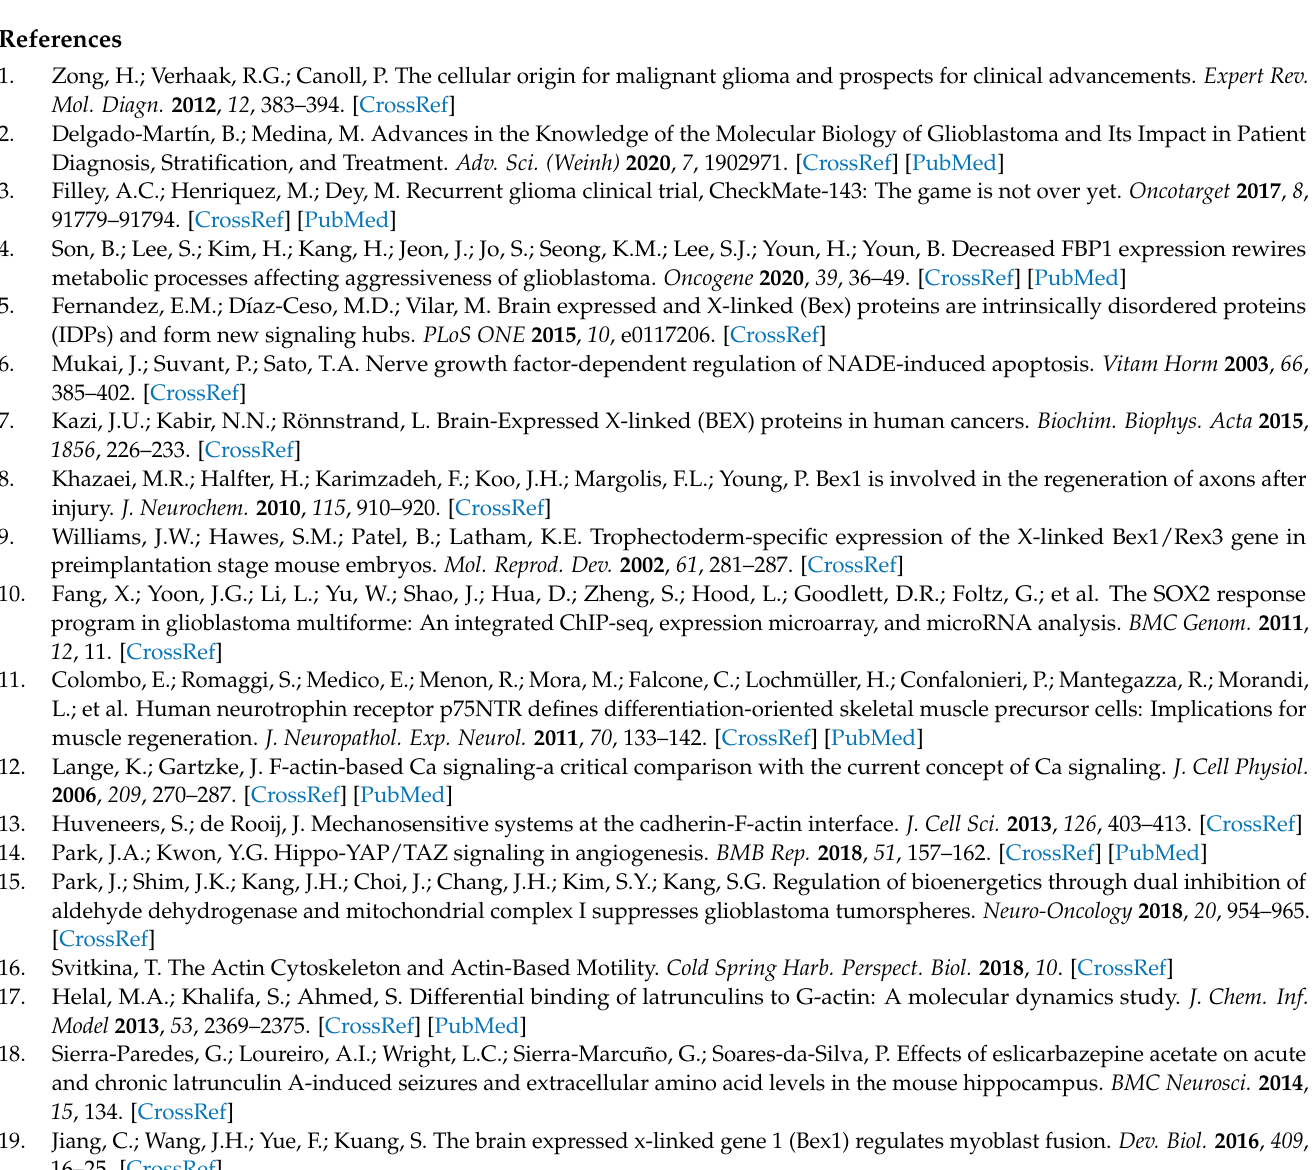
Table S1: Primers used for qRT-PCR to assess gene expression alterations, Table S2: Sequence of BEX1 and BEX4